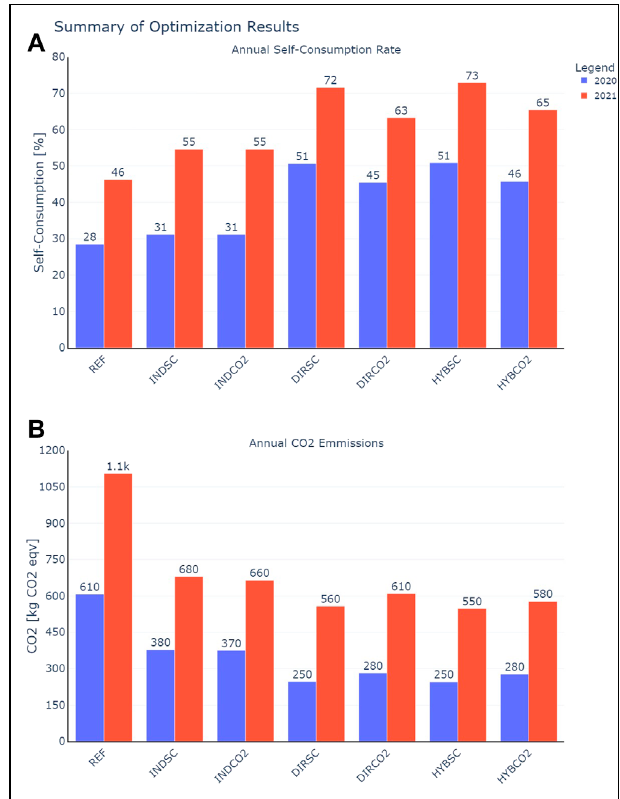
FIGURE 9 | Summary of Optimization results. (see Table 3 for x-axis interpretation). (A) Annual self-consumption rates, (B) , Annual carbon